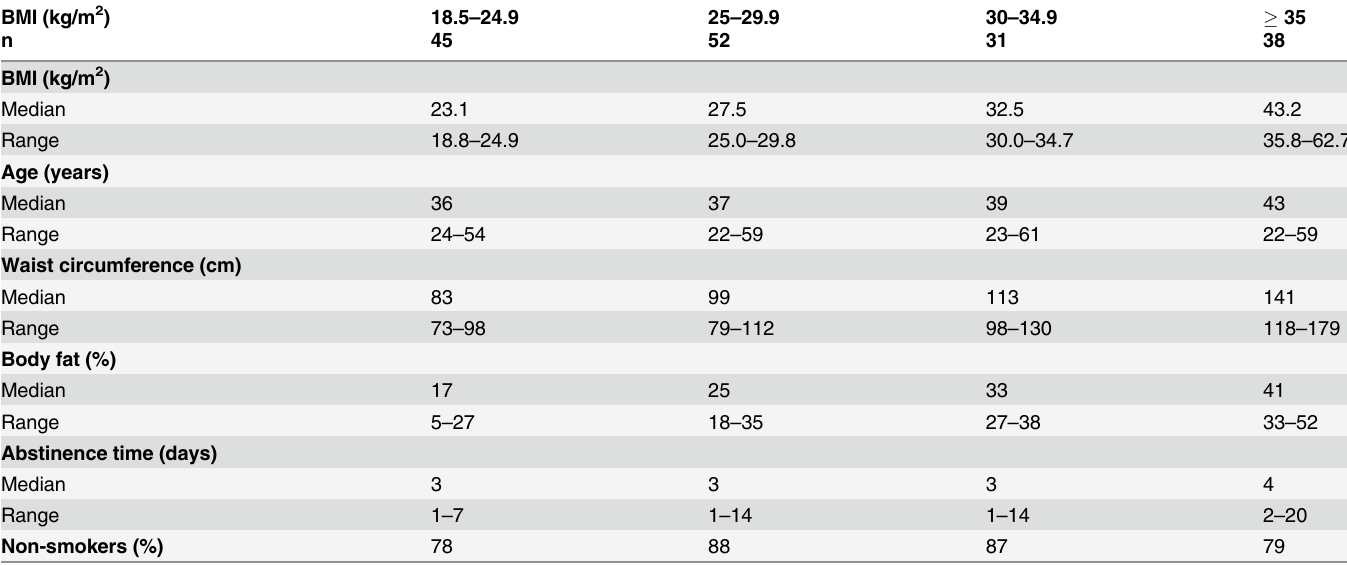
Table 1. Characteristics of the participants according to BMI